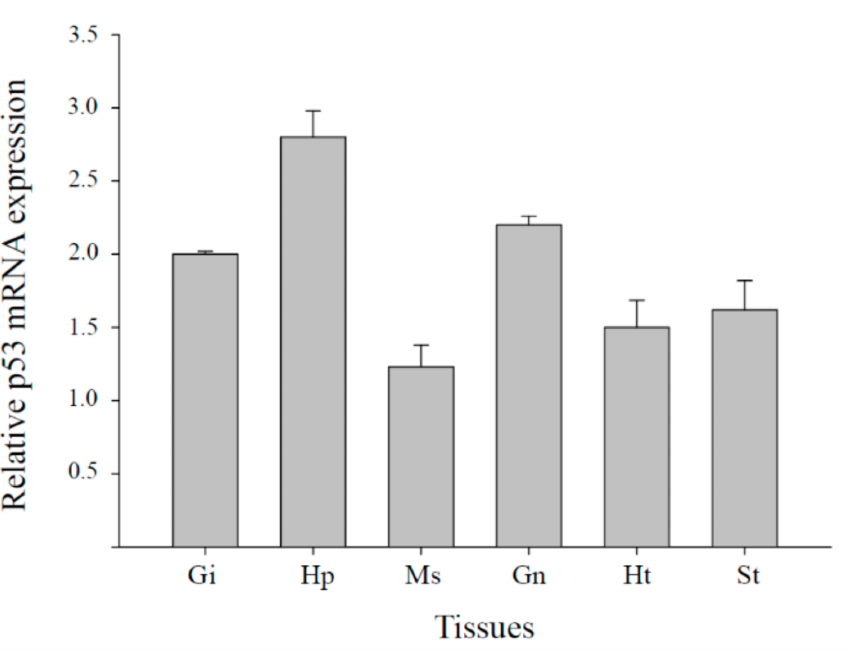
Figure 2. Basal transcriptional levels of M. japonicus p53 genes in various tissues (Gi, gills; Hp, hepatopancreas; Ht, heart; Gn, gonad; Ms, muscle; and St, stomach). All data are indicated as means ± standard deviation. Expression level of GAPDH transcripts was used for normalization of the relative transcriptional levels in each tissue from 10 crabs. The experiment was repeated three